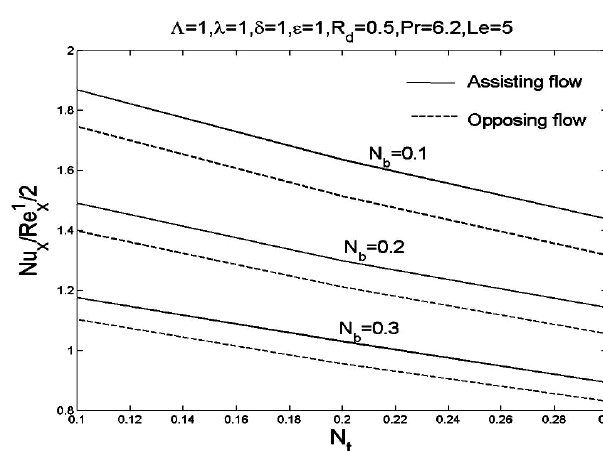
Fig. 28. The effect of the thermophoresis parameter Nt and Nb the Brownian motion parameter on the local Nusselt number .